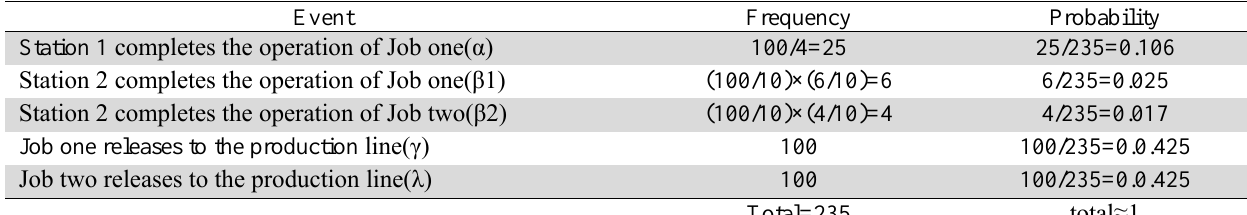
Transition probability.